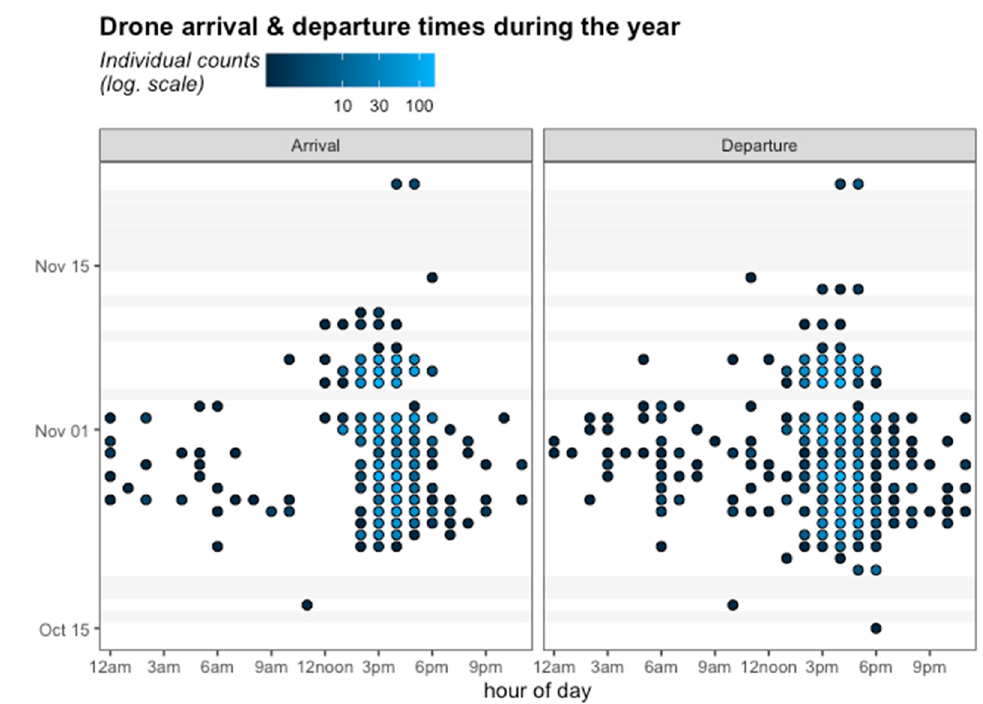
Figure 6. Arrival ( left panel ) and Departure ( right panel ) times of the drones marked with RFID in Tucumán. The color gradient goes from black to blue, where black indicates few individual counts and blue indicates more than 100 counts. Grey bars indicate days without activity.